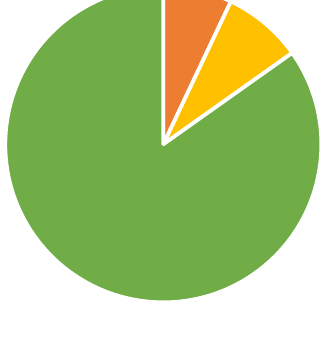
Figure 5. Daily intake of heavy metals via consumption of studied vegetables (mg kg − 1 d − 1 ) under different amendments. a RDA, 1989; b WHO, 1996; c JECFA, 2003; MTDI—maximum tolerable daily intake.